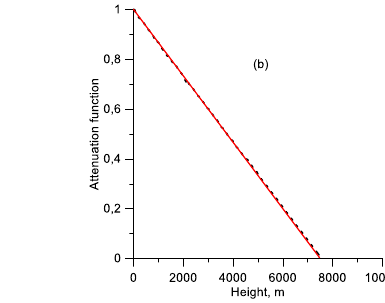
Figure 2. Attenuation curve extracted from the calculated radiation field. ( a ) MTLE model. ( b ) MTLL model. The attenuation curves are extracted from the radiation fields that would be present at a 500 km distance over perfectly conducting and flat ground.